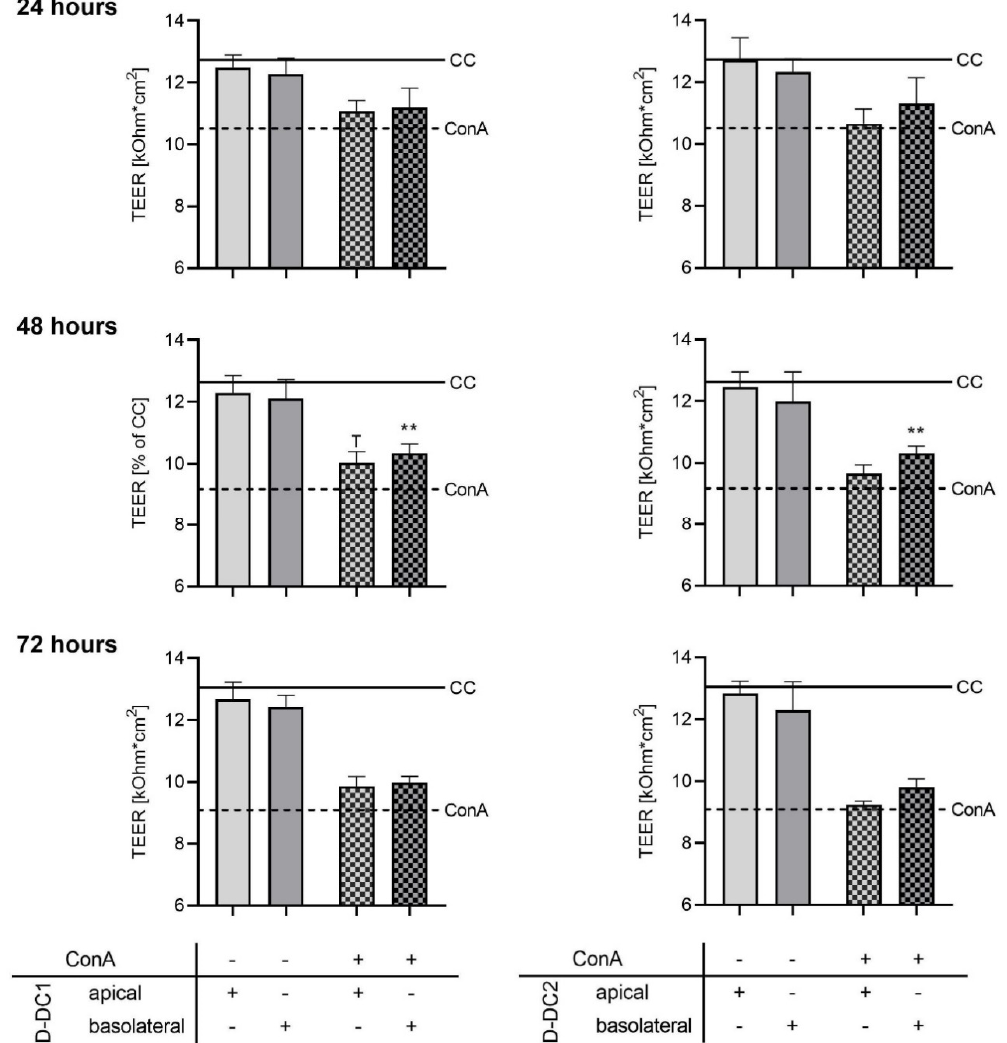
Figure 1. Effects of D-DC1 and D-DC2 extracts (applied at 150 µ g/mL) on the co-culture model of the piglet gut, with apical or basolateral application and with or without ConA-stimulation.